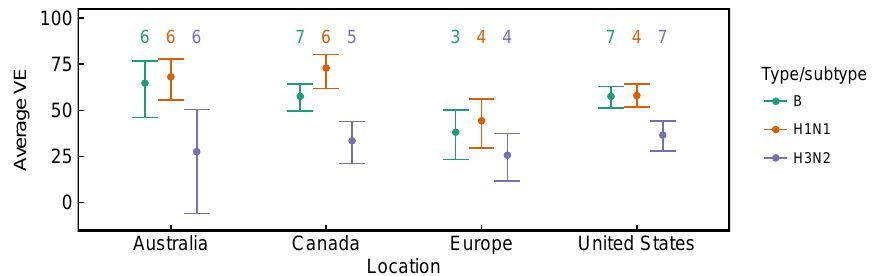
Figure A2. Seasonal VE by type and subtype averaged over time in Australia [24–26], Canada [27–34], Europe [35], and the United States [36–43] from the 2009–2010 to the 2016–2017 seasons. European VEs include data from study sites in Germany, Spain, France, Croatia, Hungary, Ireland, Italy, the Netherlands, Poland, Portugal, Romania, and Sweden. Numbers indicate the number of seasons used to calculate each mean. The specific seasons used to compute means are shown in Figure A1. Error bars show 95% CIs. Means and 95% CIs are calculated using arithmetic means of log odds ratios. (Equations